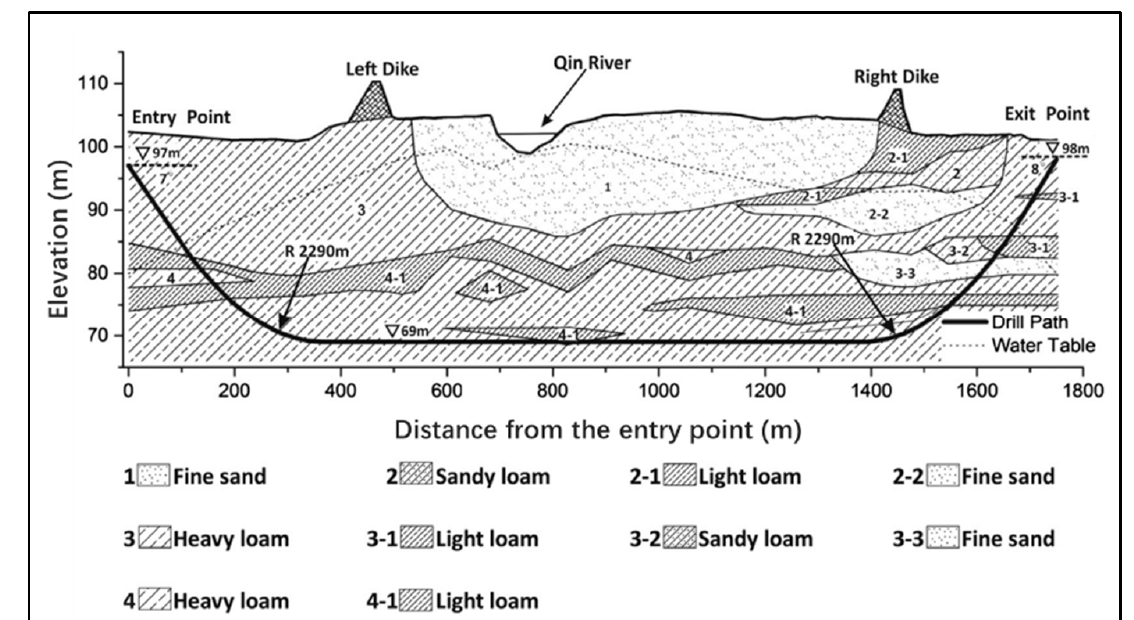
Figure 22. The drill path profile of Maxi-HDD Qin River crossing project [4]. Table 7. Parameters and range setting.